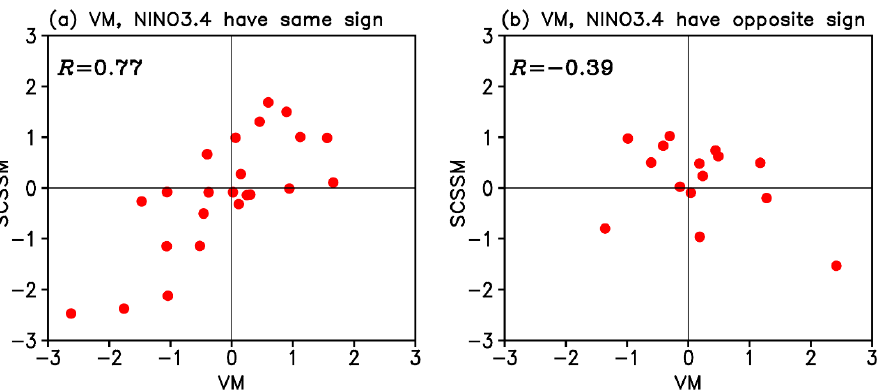
Figure 9. ( a ) Scatterplot of the FMA VMI versus the following JAS SCSSMI, plotted only for those years in which the FMA VMI has the same sign as the following DJF (December–February) Niño3.4 index; ( b ) As for ( a ) but for only those years in which the FMA VMI has the opposite sign as the following DJF Niño3.4 index. In ( a ) and ( b ), the correlation coefficient of the FMA VMI with the following JAS SCSSMI is given in the upper left corner.